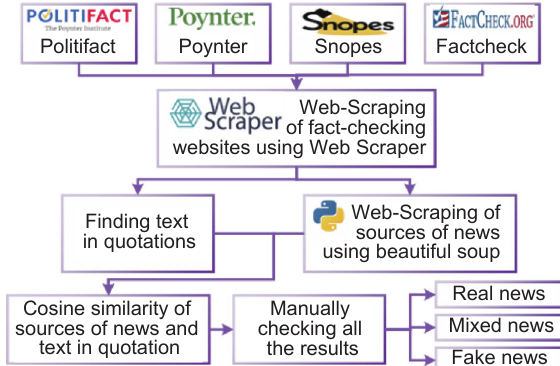
Fig. 3 Collecting news based on web-scraping and manual